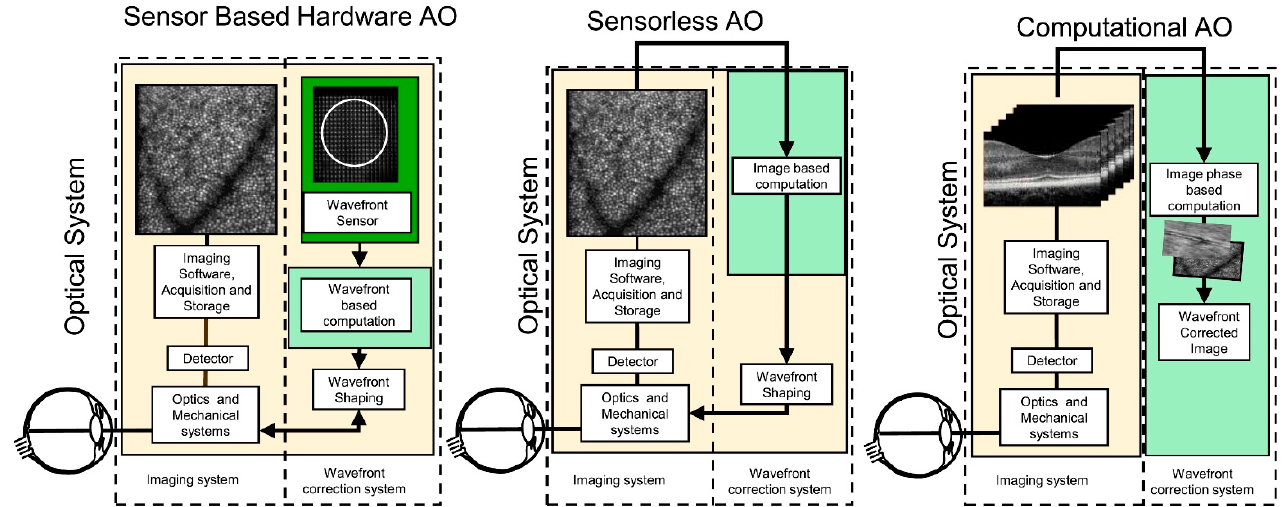
Figure 18. Different categories of AO systems. Reprinted from Ref. [98] Progress in retinal and eye research, 68, S. A. Burns, A. E. Elsner, K. A. Sapoznik, R. L. Warner and T. J. Gast, Adaptive optics imaging of the human retina, pp. 1–30, Copyright (2019) with permission from Elsevier.